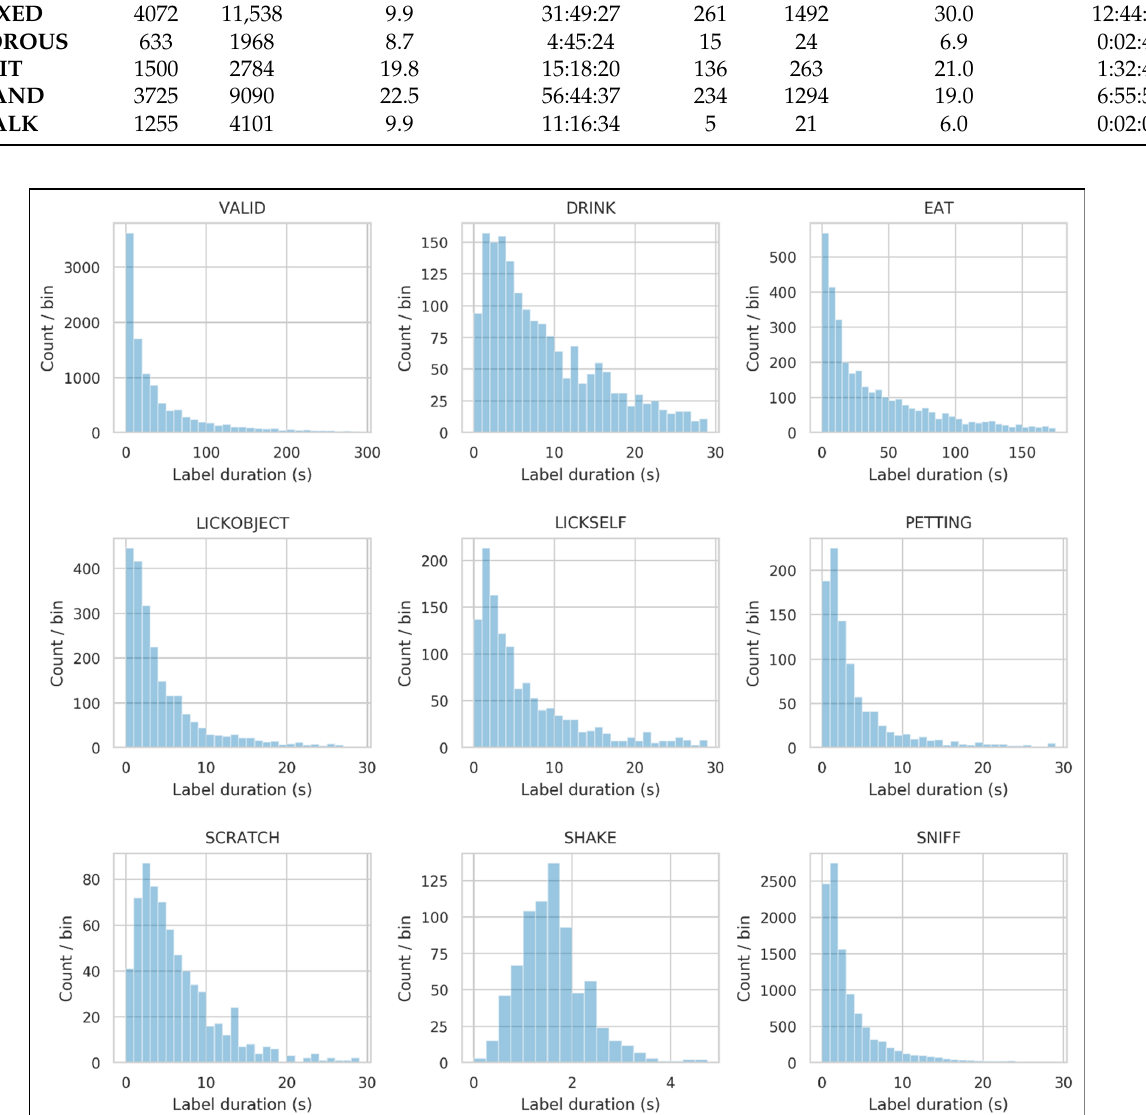
Figure 5. Distribution of label durations in the combined eat/drink and crowd datasets. Except for SHAKE, all labels exhibit a highly skewed distribution, probably the result of some longer label segments becoming fragmented.